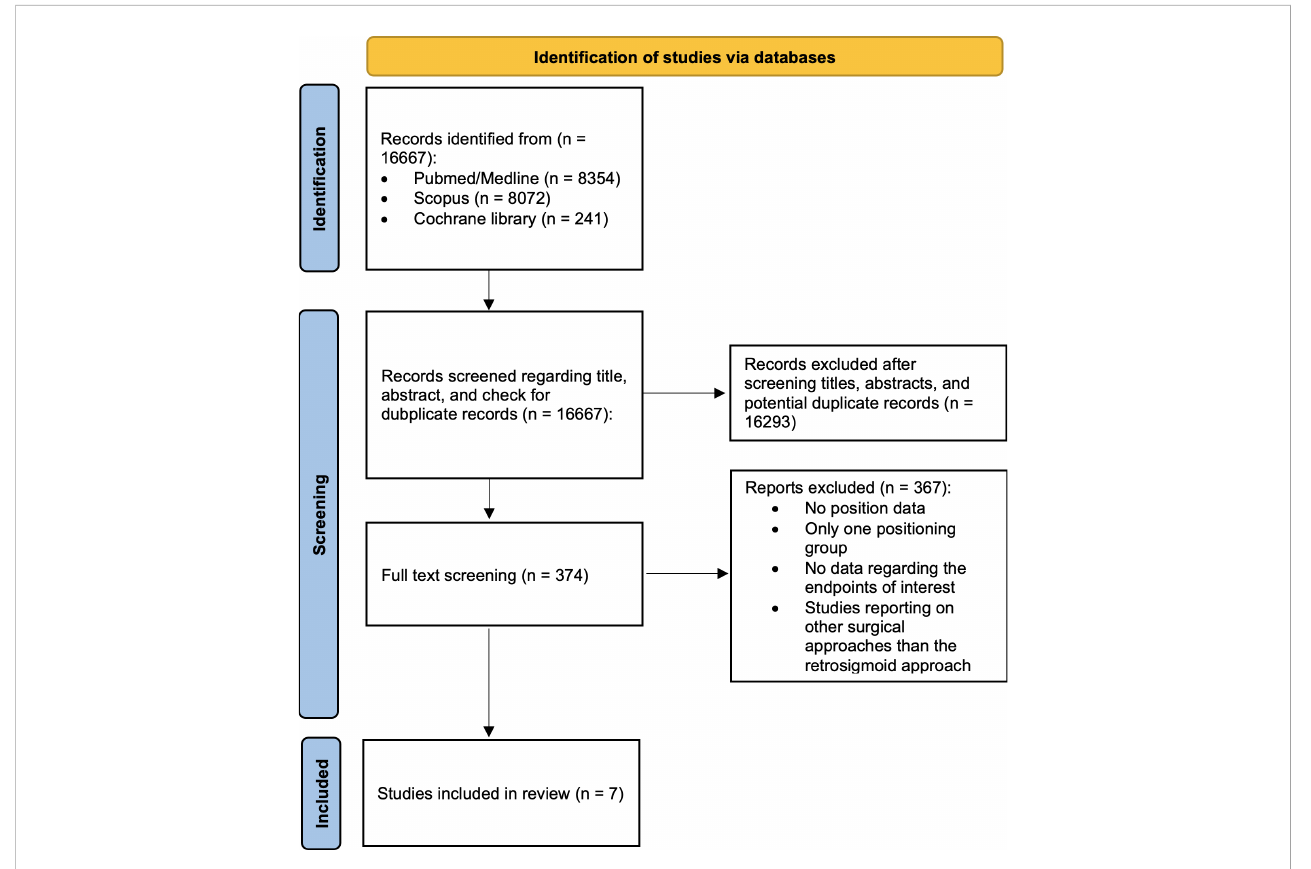
FIGURE 1 PRISMA fl ow chart illustrating the study selection of the present